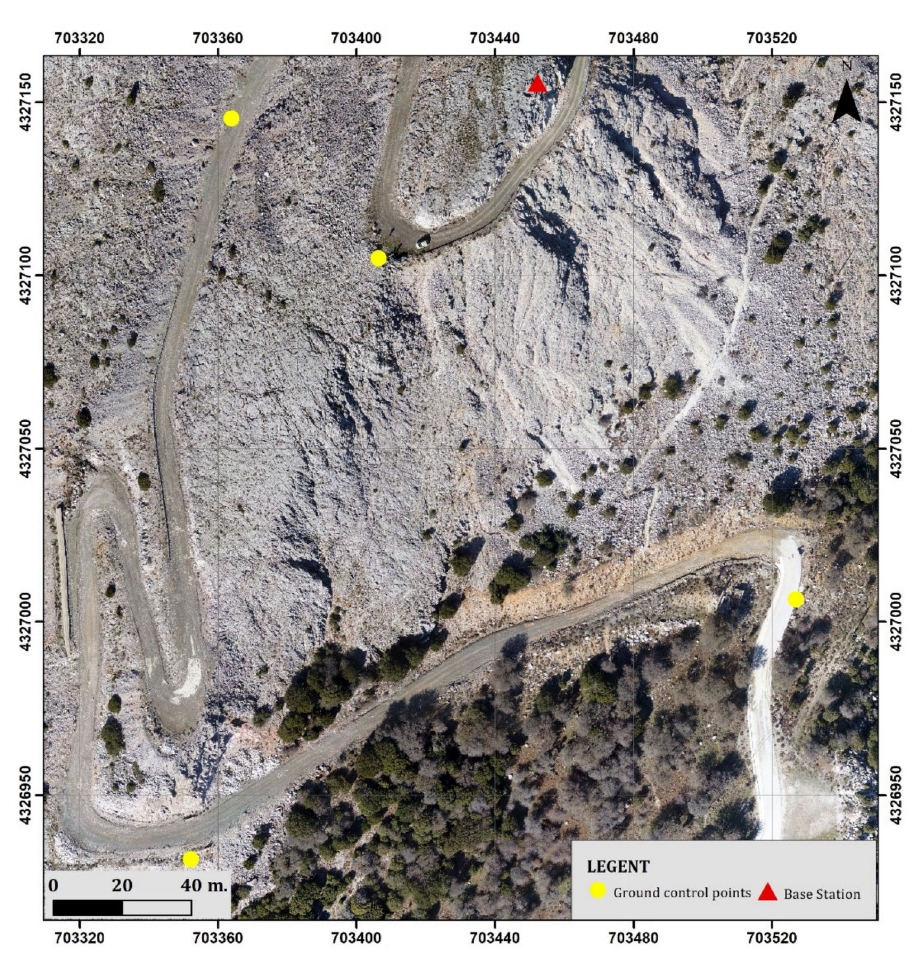
Figure 5. Map of GCP distribution measured with RTK in Olympus Mountain, Lesvos, Greece, Coordinate System: Greek Grid